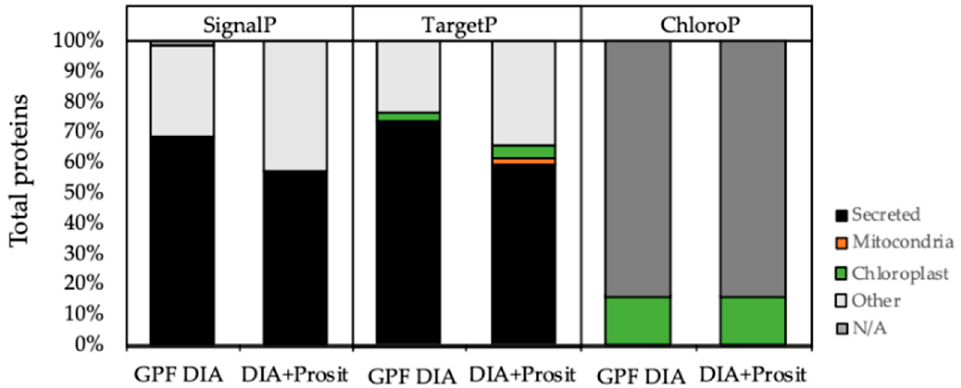
Figure 4. Subcellular localization prediction analysis and comparisons between GPF DIA and DIA + Prosit data using SignalP, TargetP, and ChloroP servers. More than 50% of the total proteins identified were predicted to have a signal peptide, according to SignalP and TargetP-SP. TargetP output revealed < 3% of total proteins containing a mitochondrial targeting peptide (mTP) and < 5% of proteins containing a chloroplast transit peptide (cTP). ChloroP predicted 16% of the collected vascular sap proteins would target the chloroplast by both methods. GPF DIA considered 145 proteins and DIA + Prosit, 360 proteins for V. vinifera .